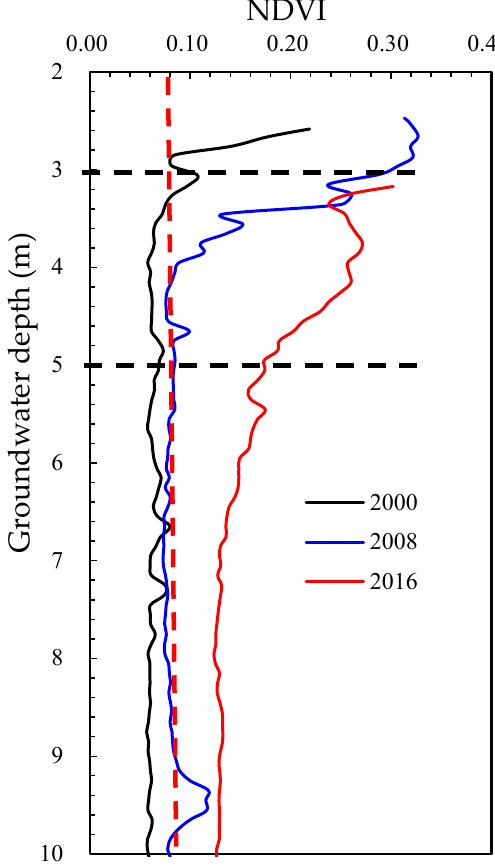
Figure 5. Relationship between NDVI and groundwater depth. Table 3. Relationship between natural vegetation growth and groundwater depth [58]. Reprinted with permission from Ref. [58]. 2021 Journal of Groundwater Science and Engineering